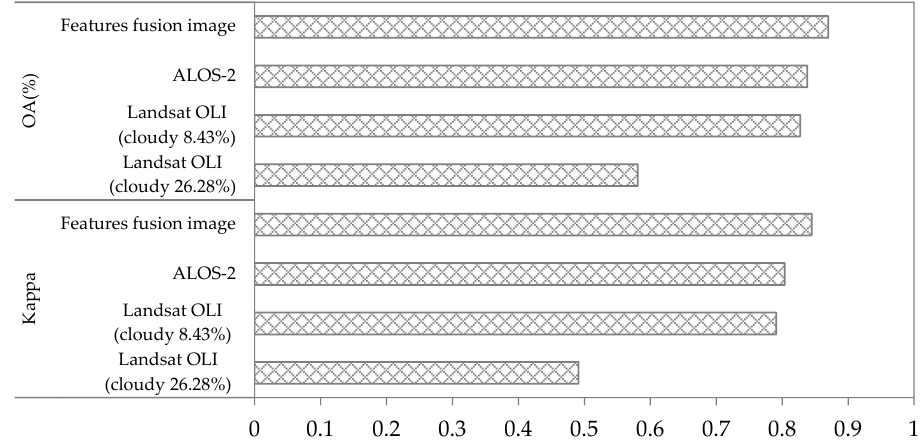
Figure 15. Comparison of the overall accuracies based on LULC classification. Appl. Sci. 2020 , 10 , x FOR PEER REVIEW